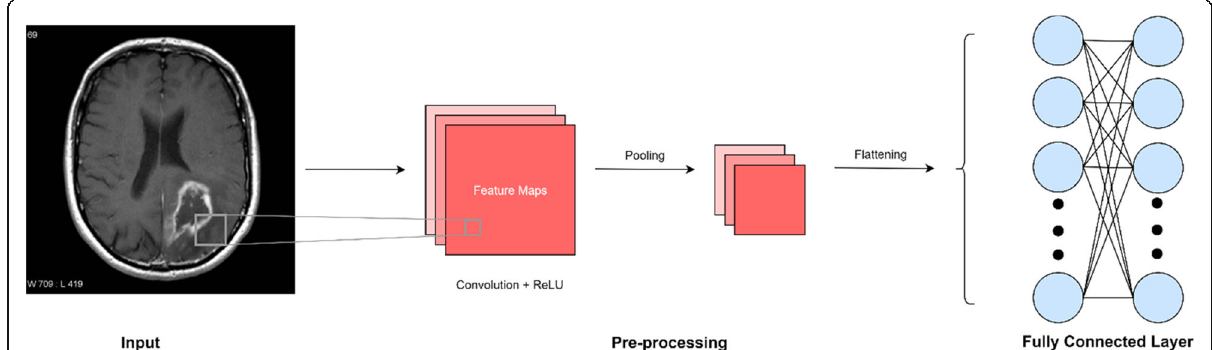
Fig. 4 Input into a single node within a convolutional neural